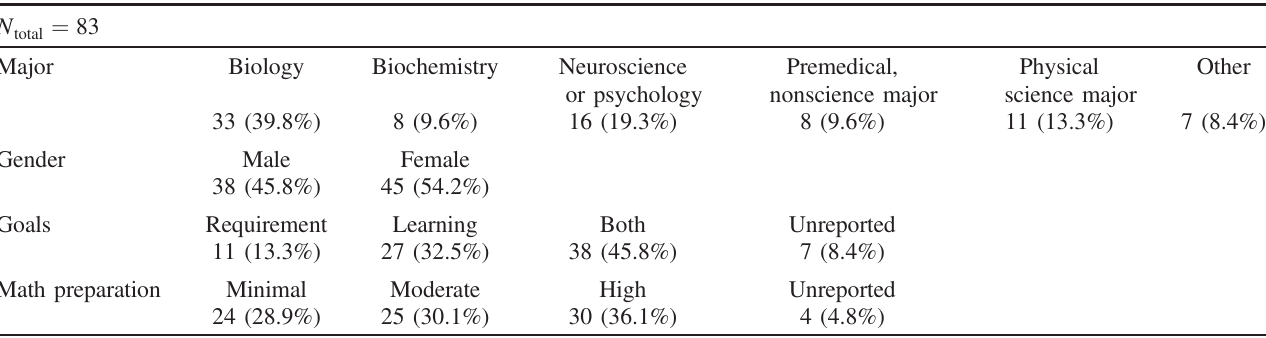
TABLE II. Characteristics of students who completed all surveys, aggregated over the three years of the study. The total number of enrolled life science students over three years was 156; the group studied was representative of the total enrollment in all of these characteristics, as verified by independent t tests. Students with “ minimal ” math background had only completed the prerequisite of a semester of single-variable calculus; “ medium ” had completed the second semester of single-variable calculus; and “ high ” had completed further mathematics (linear algebra and/or multivariable